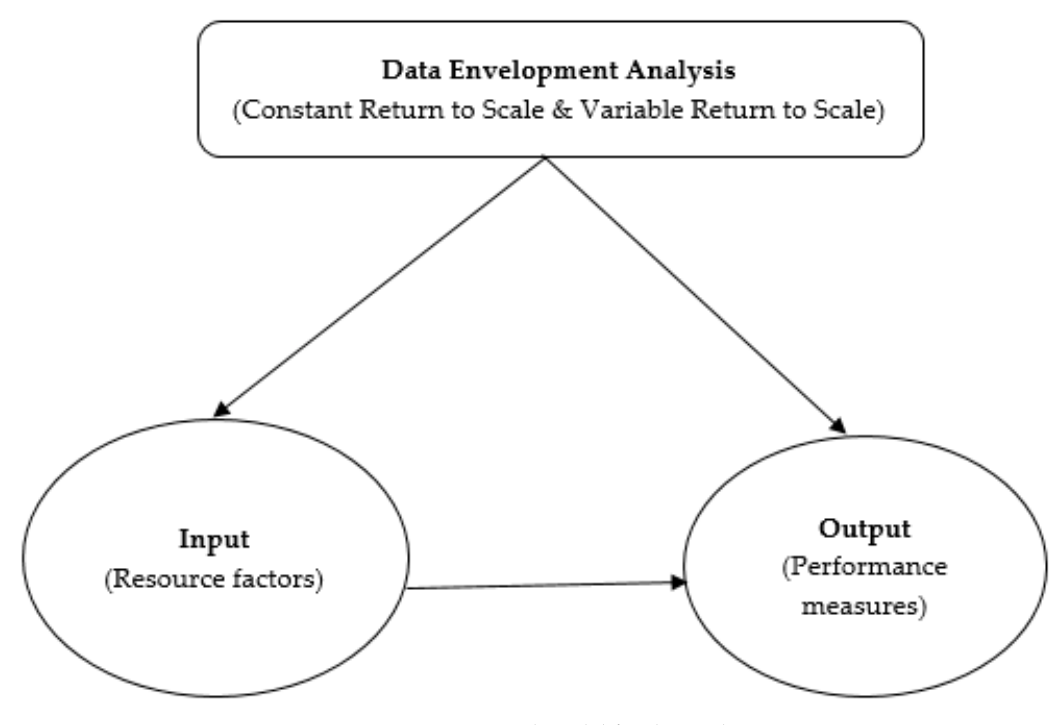
Figure 1. Conceptual model for the study.